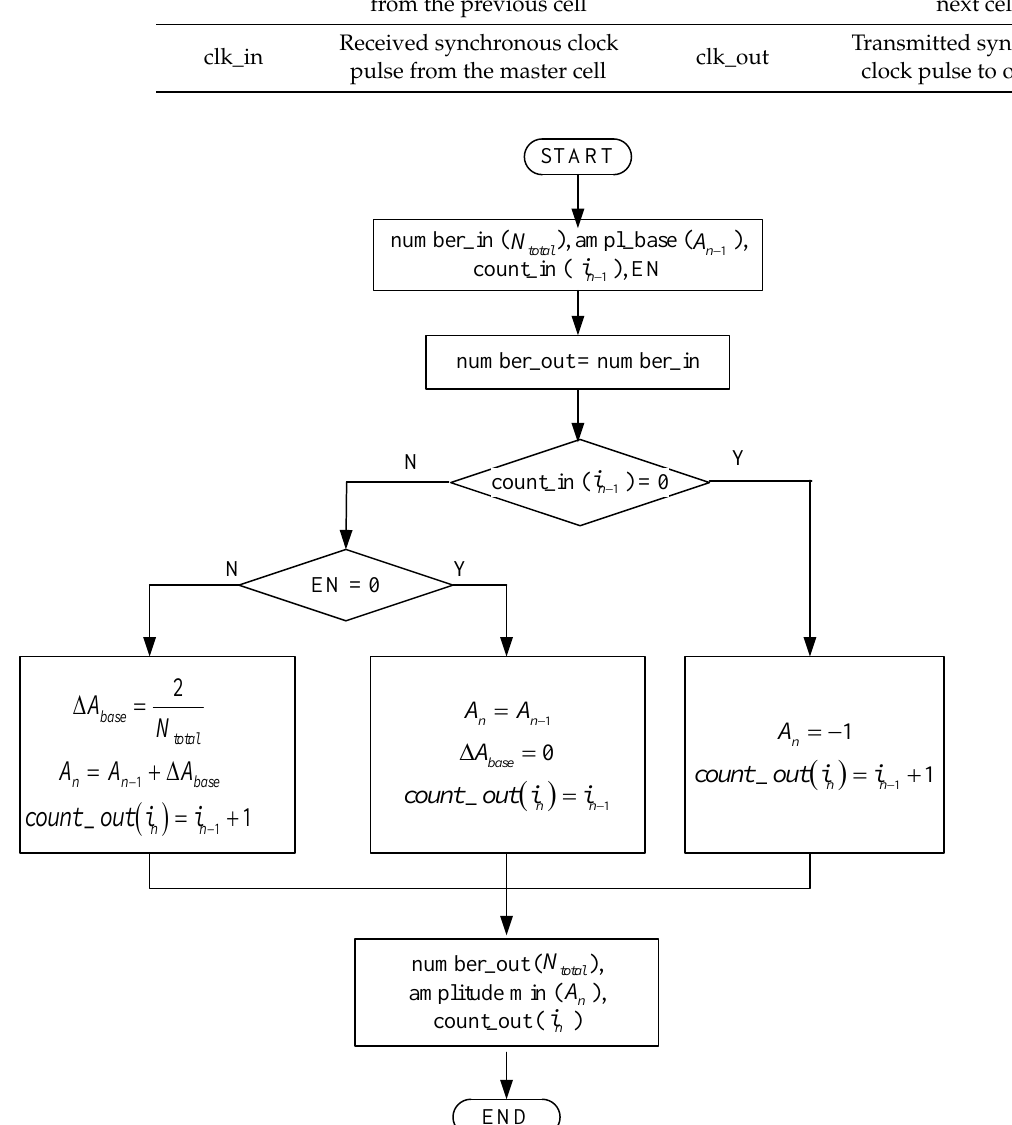
Figure 8. Algorithm flowchart of the proposed DSA-LSC method.